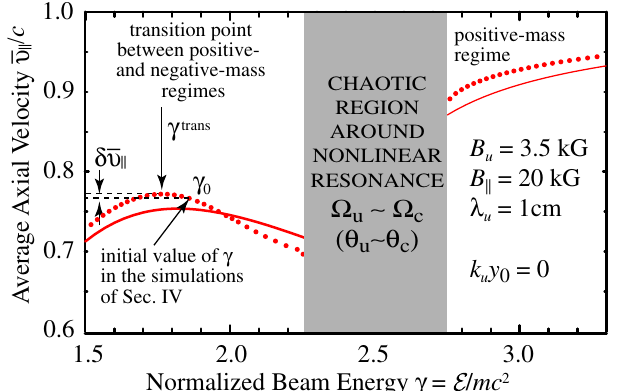
FIG. 3. Illustration of the negative-mass effect for a test elec- tron in the pump field. The average axial velocity is a function of the beam energy. The curves are obtained using analytical formulas (17) and (18) while the dots represent the results of the numerical simulation.